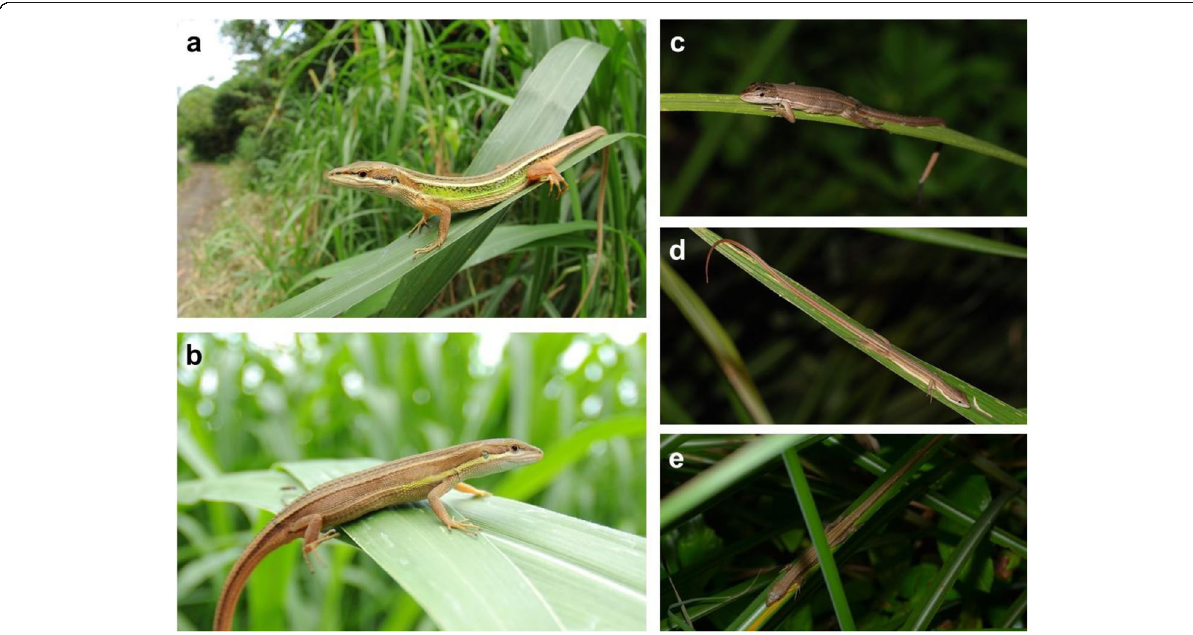
Fig. 1 Takydromus viridipunctatus is characterized by its greenish nuptial color on males ( a ) in the breeding season. In contrast, females ( b ) are brownish all year round. The specialized perching behavior on the grasses ( c , d , e ) makes them an excellent target for testing the “ arboreal hypothesis ” of invariant clutch size